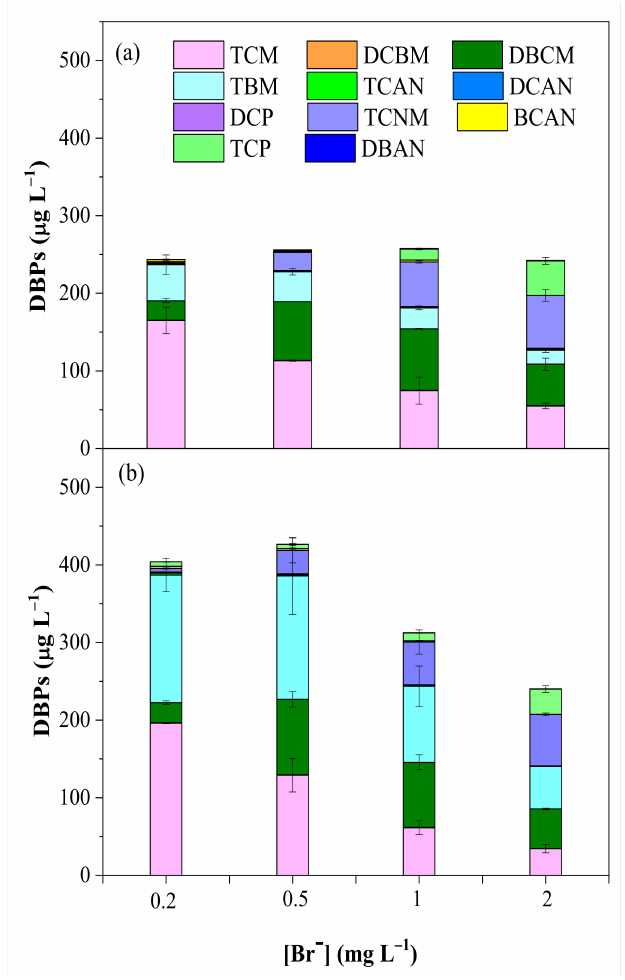
Figure 7. Effect of Br – on the formation potential of DBPs: ( a ) PM process and ( b ) PM/BS process. ((HA) o = 3 mg L − 1 , (PM) o = 50 µ M, (BS) o = 250 µ M and (Br − ) o = 0.1–2 mg L − 1 ). Duplicated samples were